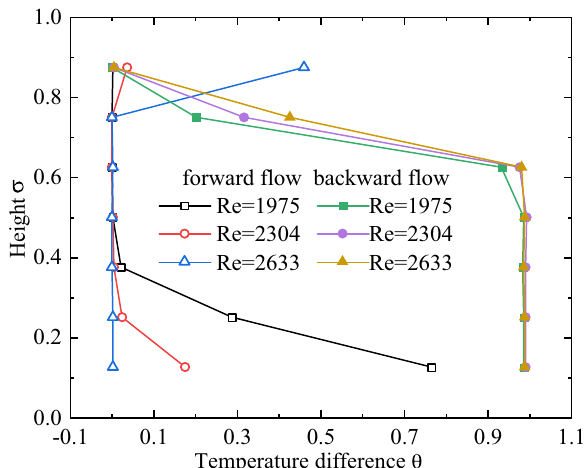
Fig. 12 Temperature change of L2 in both flow modes when Fo is 1.8